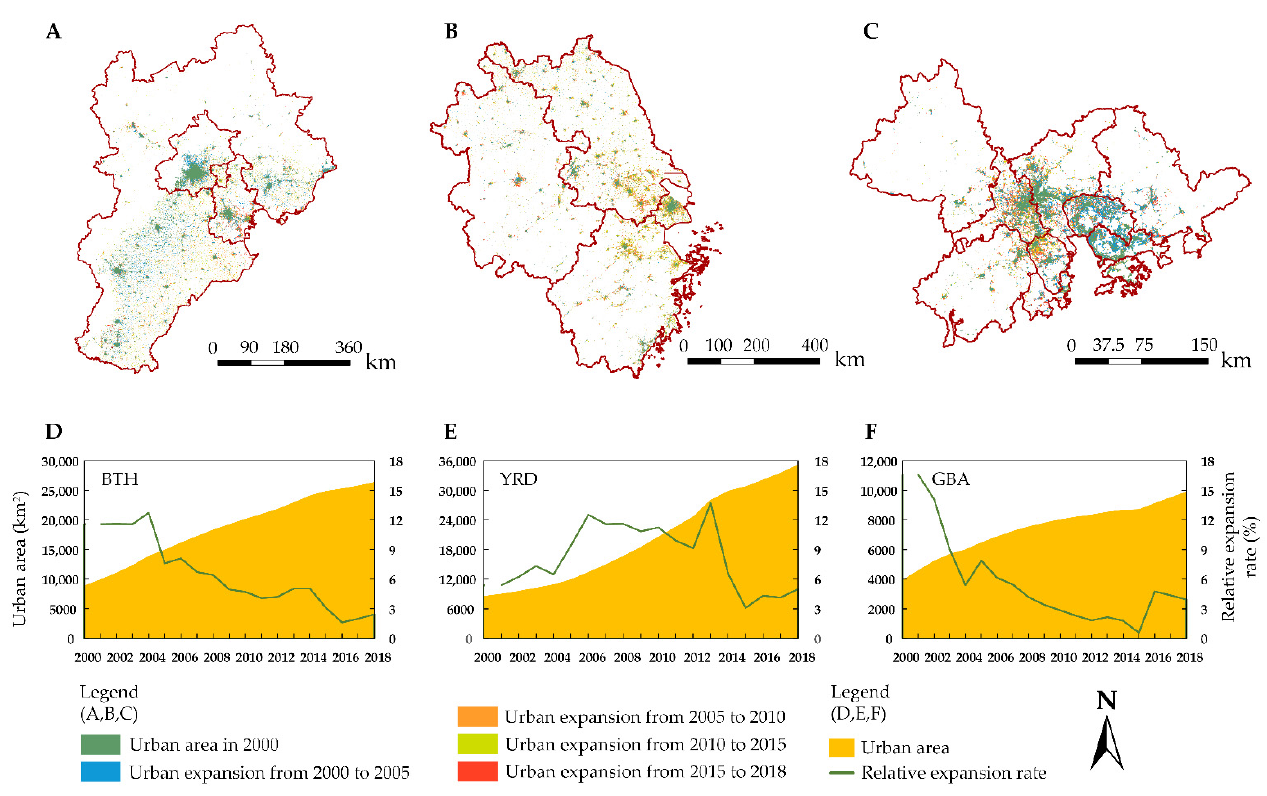
Figure 6. ( A – C ) Urban area extracted from NTL images of BTH, YRD, and GBA, respectively. ( D – F ) The trends of urban areas and their relative expansion rates in three urban agglomerations in different years from 2000 to 2018.